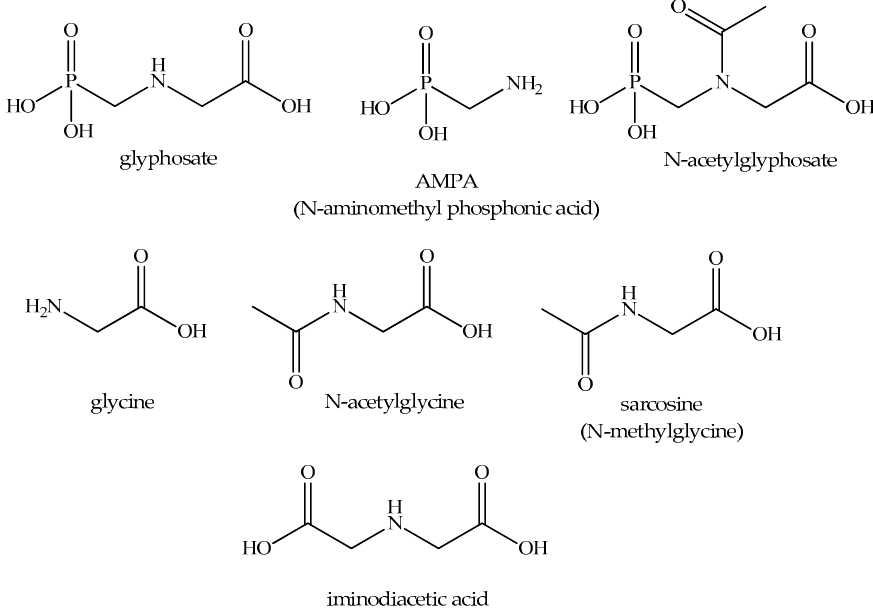
Figure 3. Chemical structures of the ligands (the active herbicide ingredient glyphosate and its structural analogs) investigated in this study. Table 1. Physicochemical properties of the ligands studied.